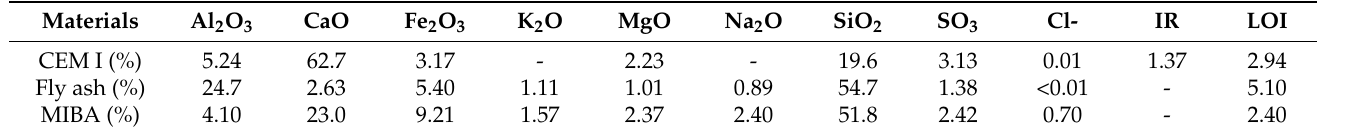
Table 2. Chemical characterization for cement, FA and MIBA (% by